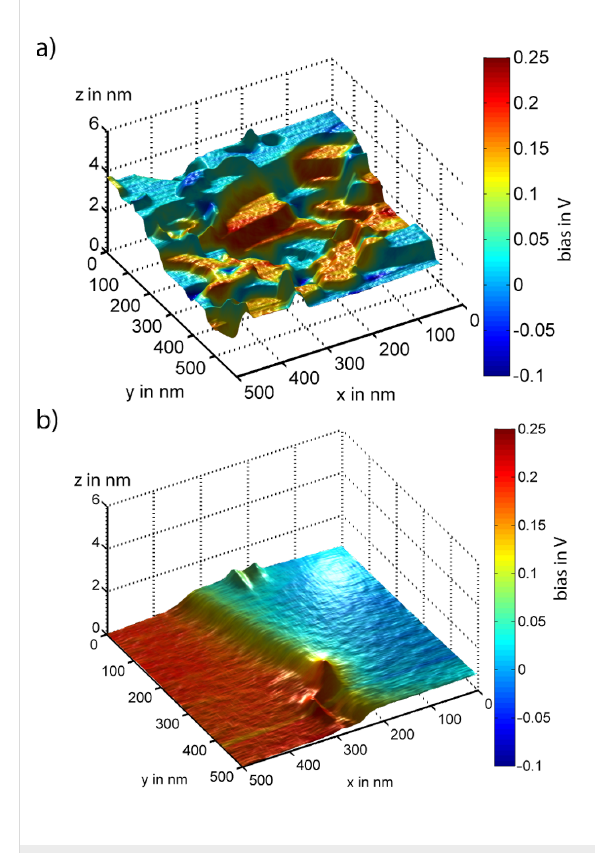
Figure 4: Rendered images of graphene layers on SiC(0001) prepared in (a) UHV and (b) an argon atmosphere. The colour represents the local contact potential. Bluish colour indicates single-layer graphene, reddish colour double-layer graphene. change in step height. The much simpler surface structure